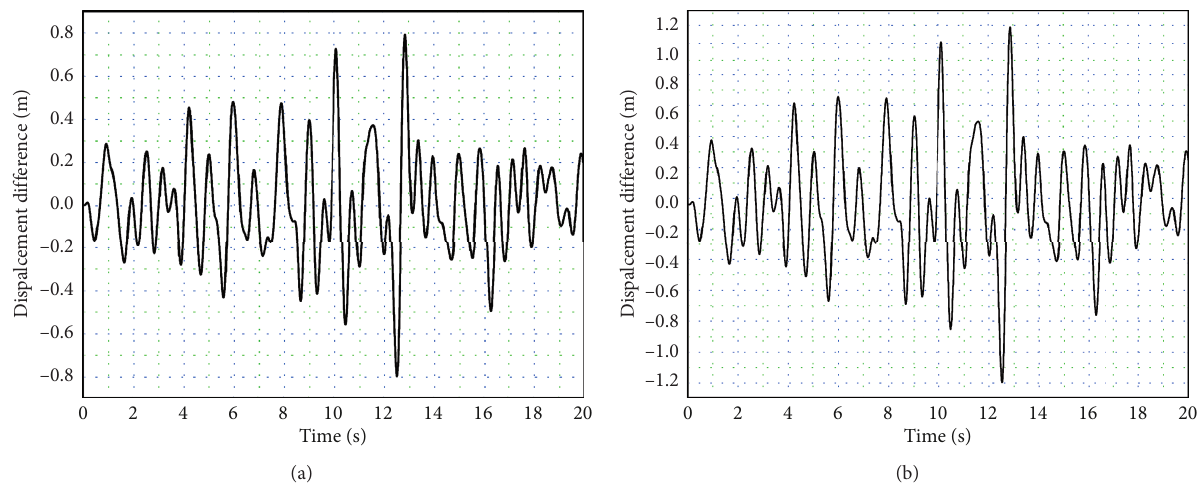
Figure 10: Displacement responses of surrounding rocks. (a) Normal surrounding rock. (b) Surrounding rock within the fault